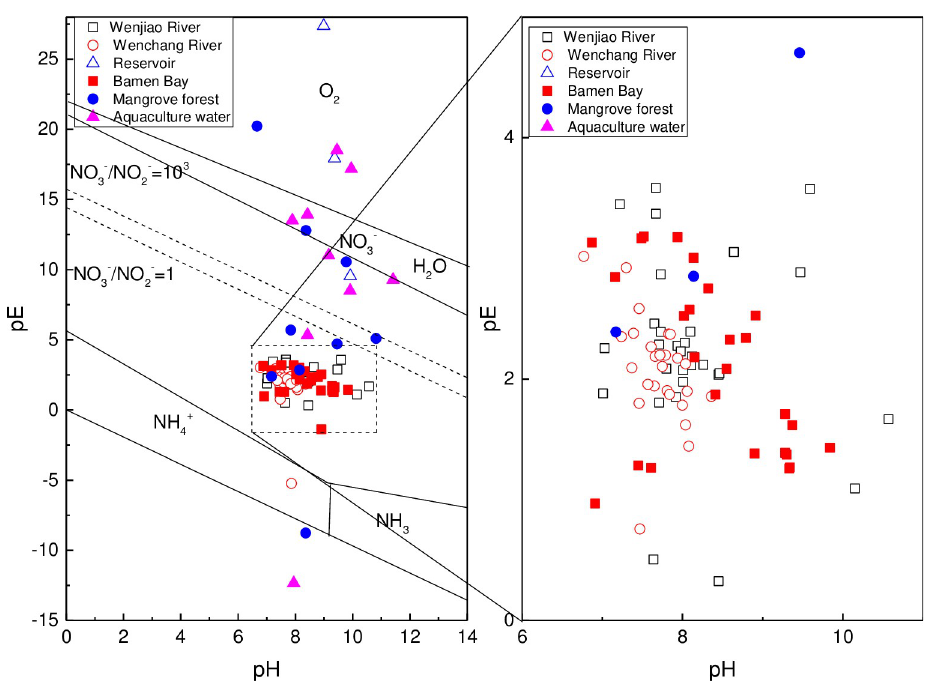
Fig 12. pH–pE diagram of surface water samples in the Bamen Bay